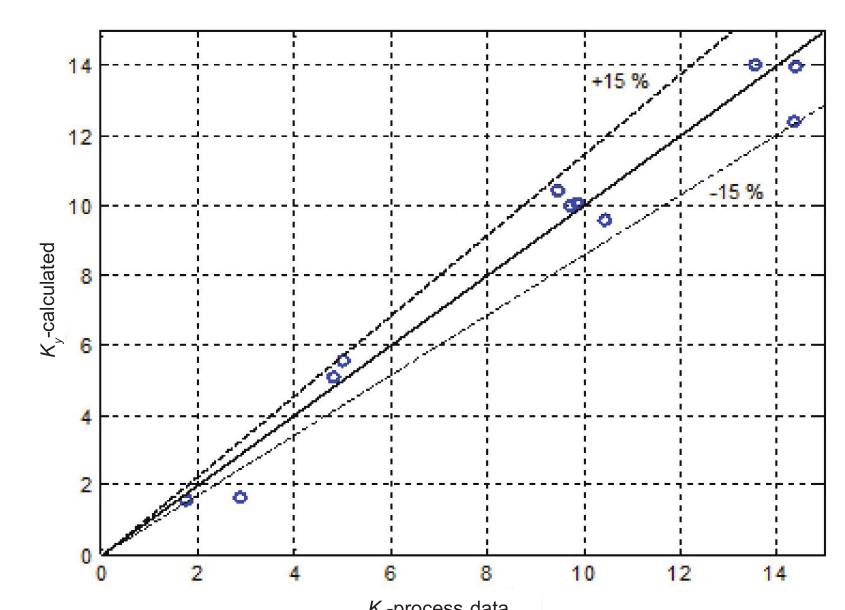
Fig. 8 – Comparison between calculated values of K